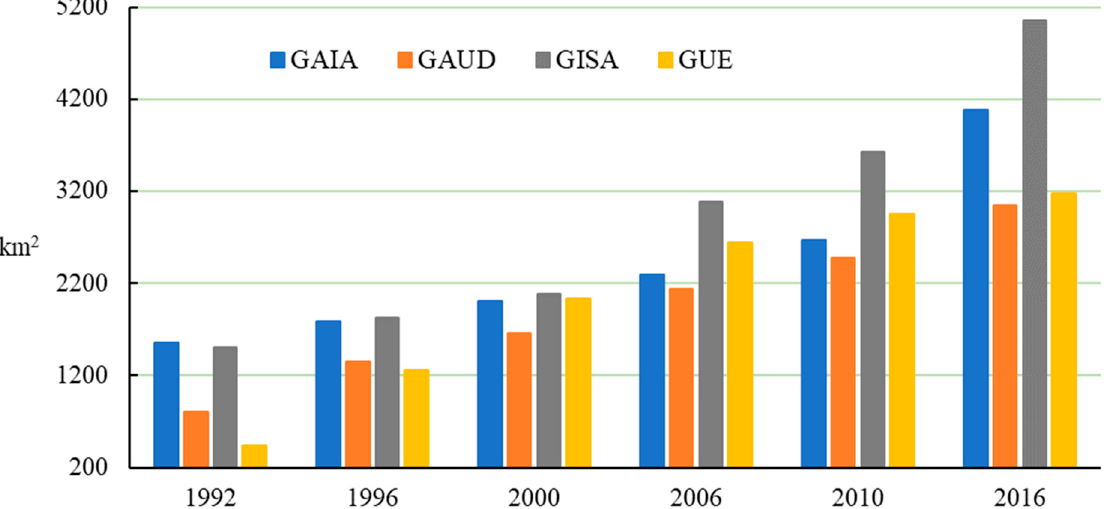
Figure 3. ISA changes in the HKH region interpreted by the four ISA datasets in representative years 1992, 1996, 2000, 2006, 2010, and 2016.